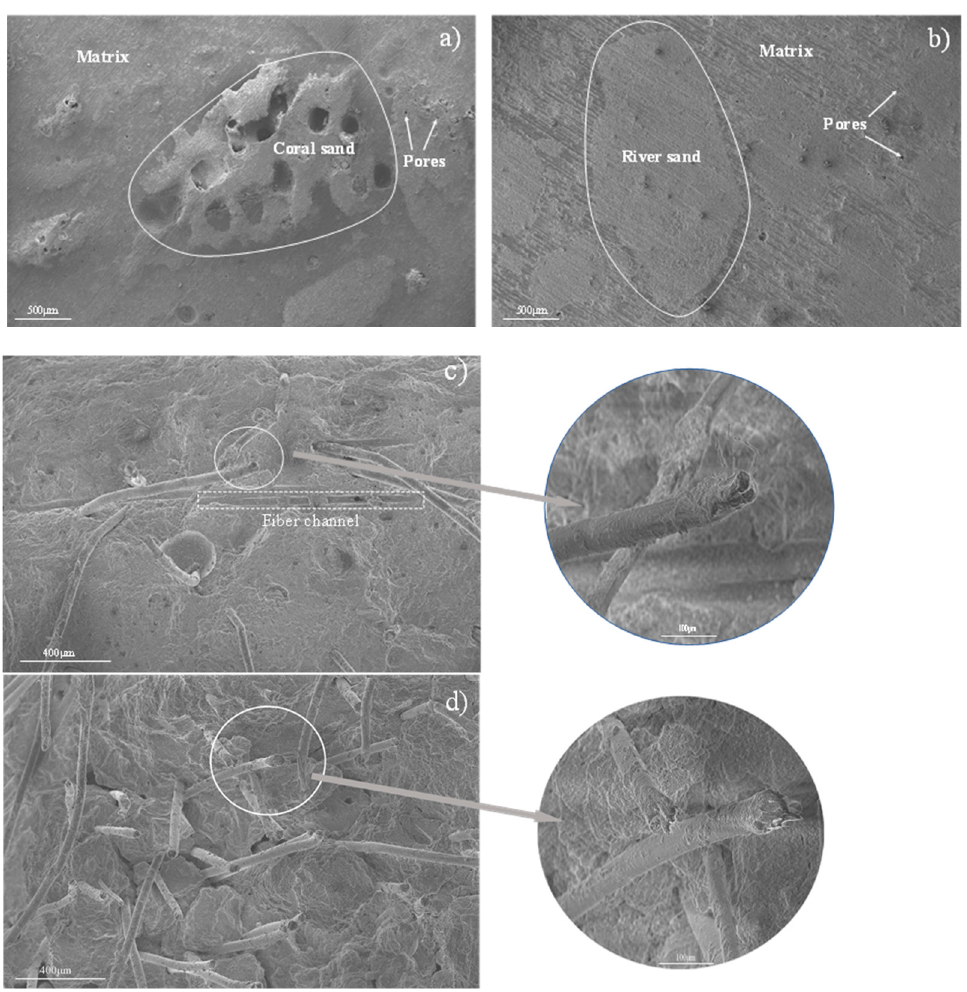
Figure 10. Microstructure of the mortar: ( a ) SCM-1; ( b ) SCM-4; ( c ) friction-damaged microstructure of PVA fiber ends; ( d ) fracture-damaged microstructure of PVA fiber